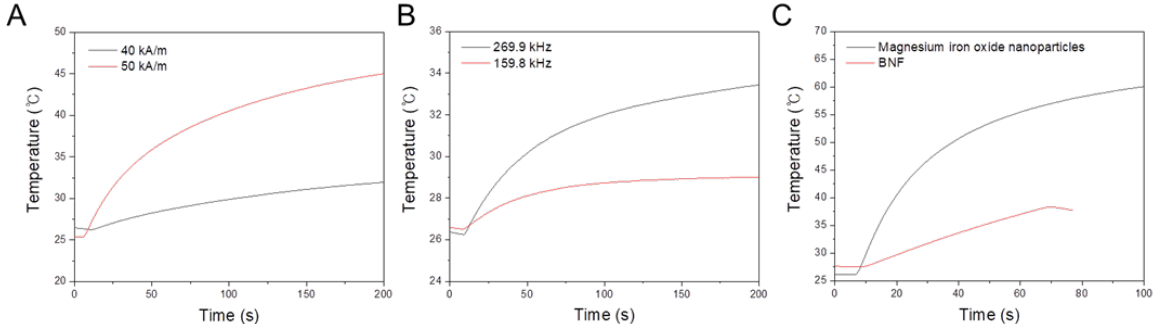
Figure 5. Temperature elevation by ( A ) MgIONPs@TMAH in response to the application of AMF with a constant frequency of 97 kHz, while varying the strength from 40 to 50 kA/m. ( B ) MgIONPs@TMAH in response to the application of an AMF with a constant strength of 13.5 kA/m, while varying the frequency from 159.8 to 269.9 kHz. ( C ) MgIONPs@TMAH (36.5 mg/mL) and BNF NPs (60 mg/mL) with the application of an AMF having a frequency of 614.4 kHz and a strength of 9.5 kA/m.